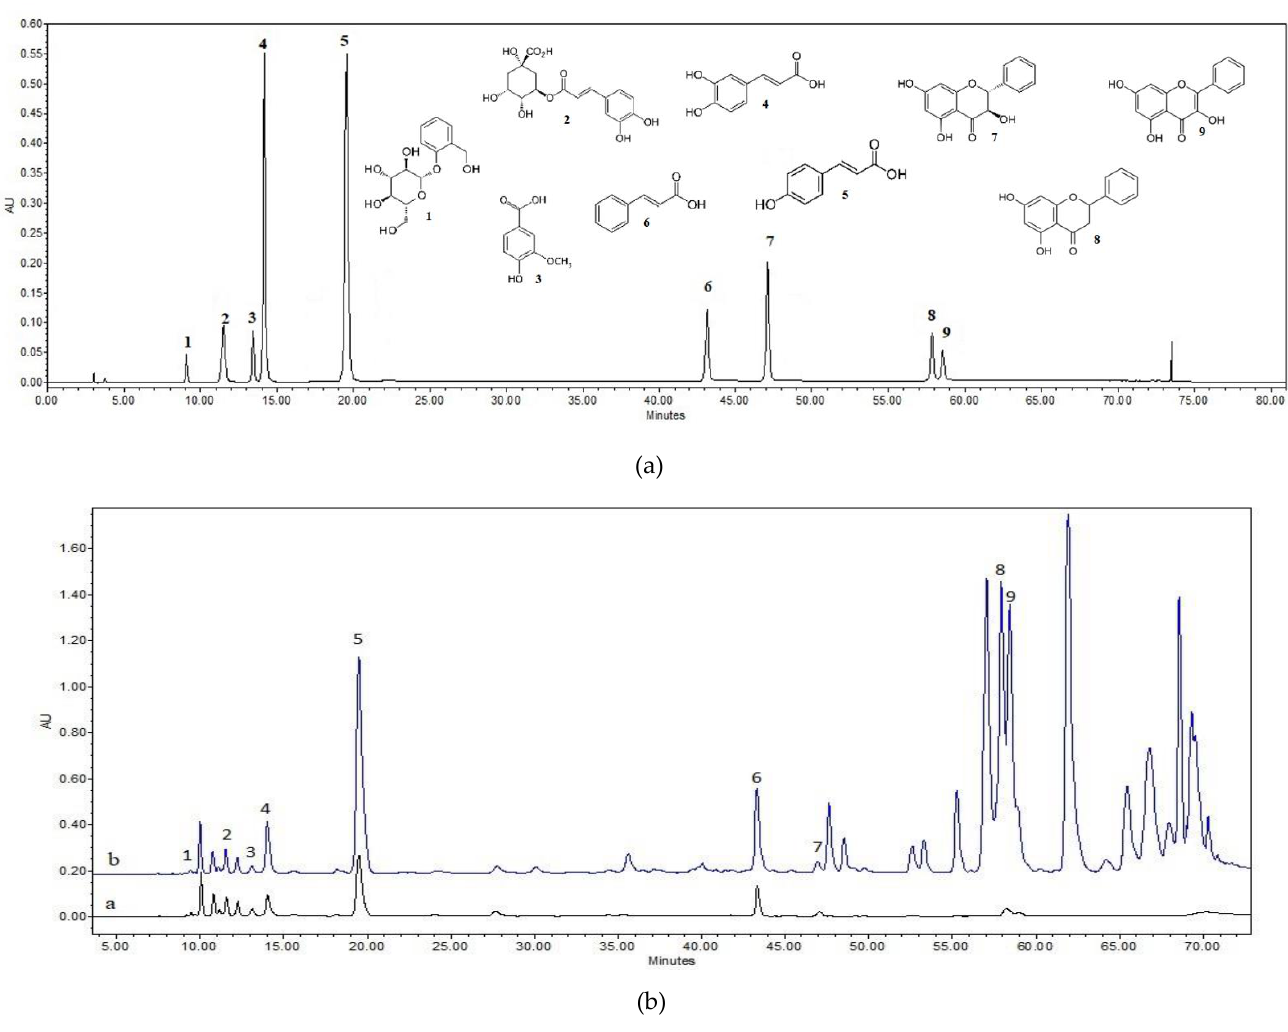
Figure 1. HPLC chromatograms of the standard compounds and identified compounds in the extracts. Upper Standard compounds’ chromatogram: 1. salicin (RT = 9.042; R 2 = 0.9999), 2. chlorogenic acid (RT = 11.538; R 2 = 0.9999), 3. vanillic acid (RT = 13.456; R 2 = 0.9999), 4. caffeic acid (RT = 14.084; R 2 = 0.9999), 5. p -coumaric acid (RT = 19.669; R 2 = 0.9999), 6. cinnamic acid (RT = 43.246; R 2 = 0.9999), 7. pinobanksin (RT = 47.158, R 2 = 0.9999), 8. pinocembrin (RT = 57.967; R 2 = 0.9998), 9. galangin (RT = 58.636; R 2 = 0.9998). The lower chromatogram shows the identified compounds of the aqueous dried balsam poplar bud extract B1U ( a ) and the ethanolic dried balsam poplar bud extract B2U ( b ) extracted by ultrasound: 1. salicin, 2. chlorogenic acid, 3. vanillic acid, 4. caffeic acid, 5. p -coumaric acid, 6. cinnamic acid, 7. pinobanksin, 8. pinocembrin, 9. galangin.